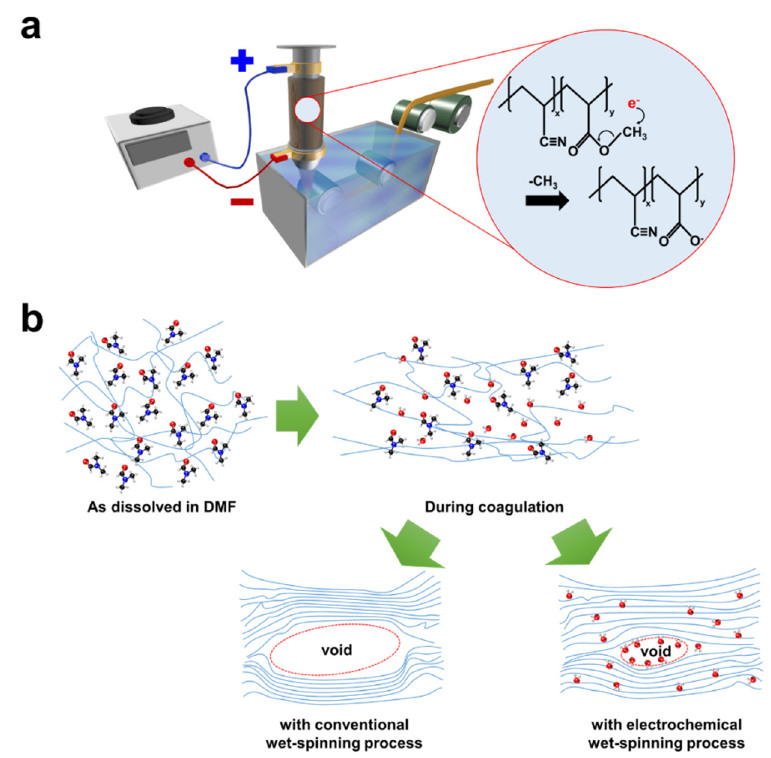
Figure 9. Schematics of ( a ) the electrochemical wet spinning process and ( b ) the molecular changes occurring therein. Note that no air gap was present between the spinneret and the coagulation bath (reprinted with permission from [81] , copyright 2020 Elsevier).